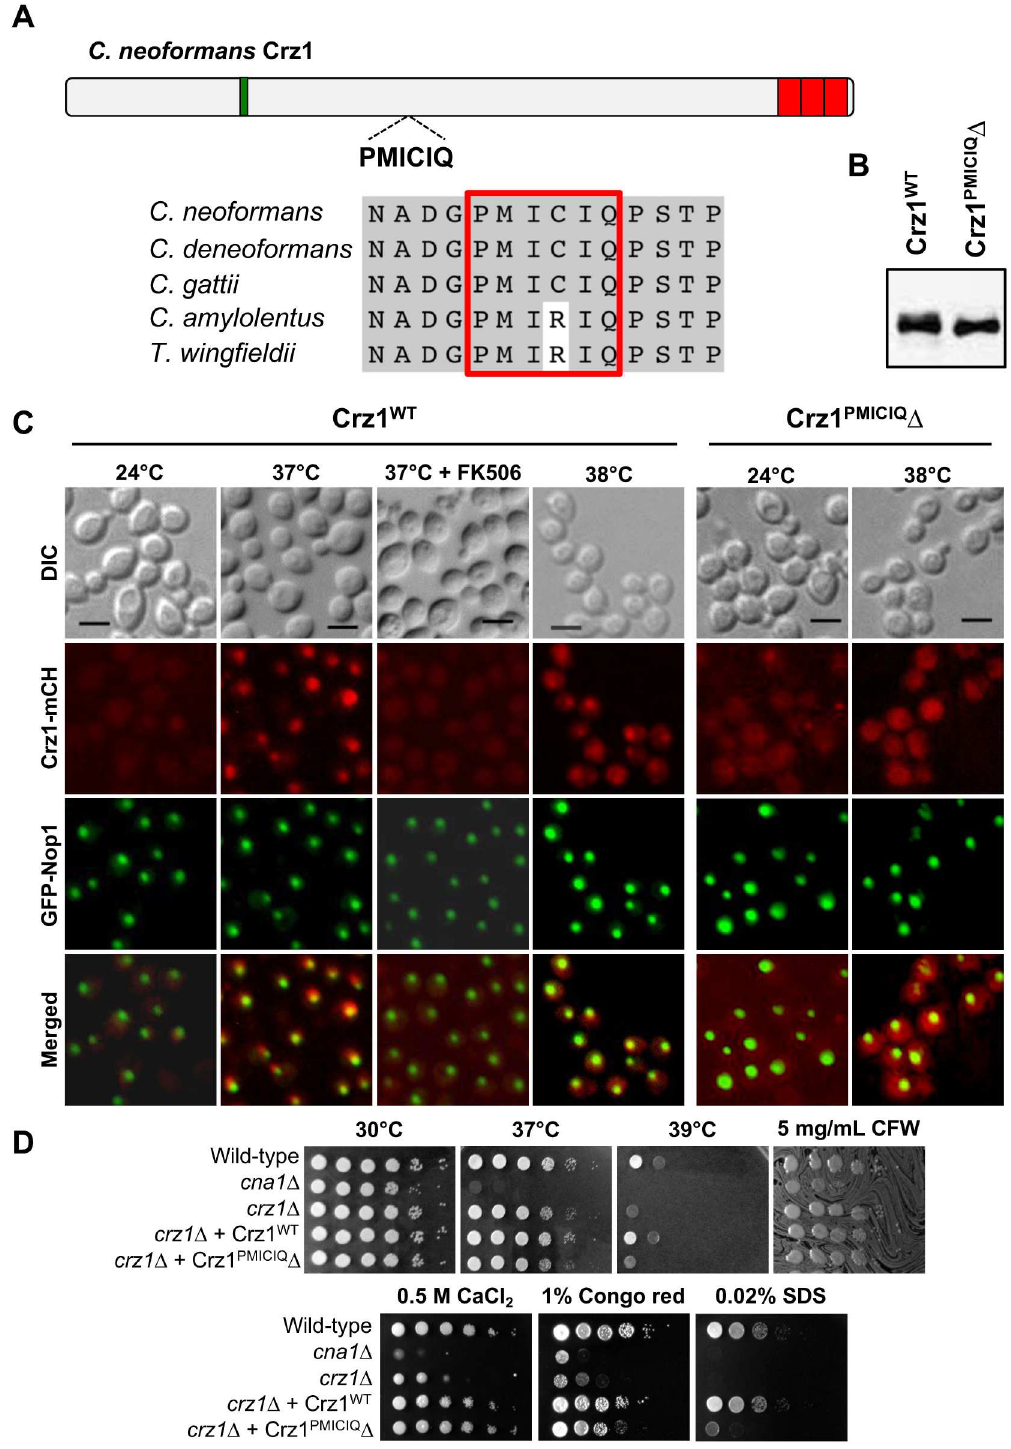
Fig 1. Deletion of the 451 PMICIQ 456 motif prevents translocation of Crz1 into the nucleus under thermal stress.(A) Schematic diagramshowingthe location of the candidate 451 PMICIQ 456 motif. The PMICIQ motif is conservedin the pathogenic species complex.The green box represents the PolyQ domain;red boxes represent the zinc finger domains. (B) Strains ECt172 (Crz1 WT ) and ECt386 (Crz1 PMICIQ Δ ) were grown overnight at 24˚C, washed, and total cell lysates were extracted. Samples were resolved by SDS-PAGE and Western blottingwas performed